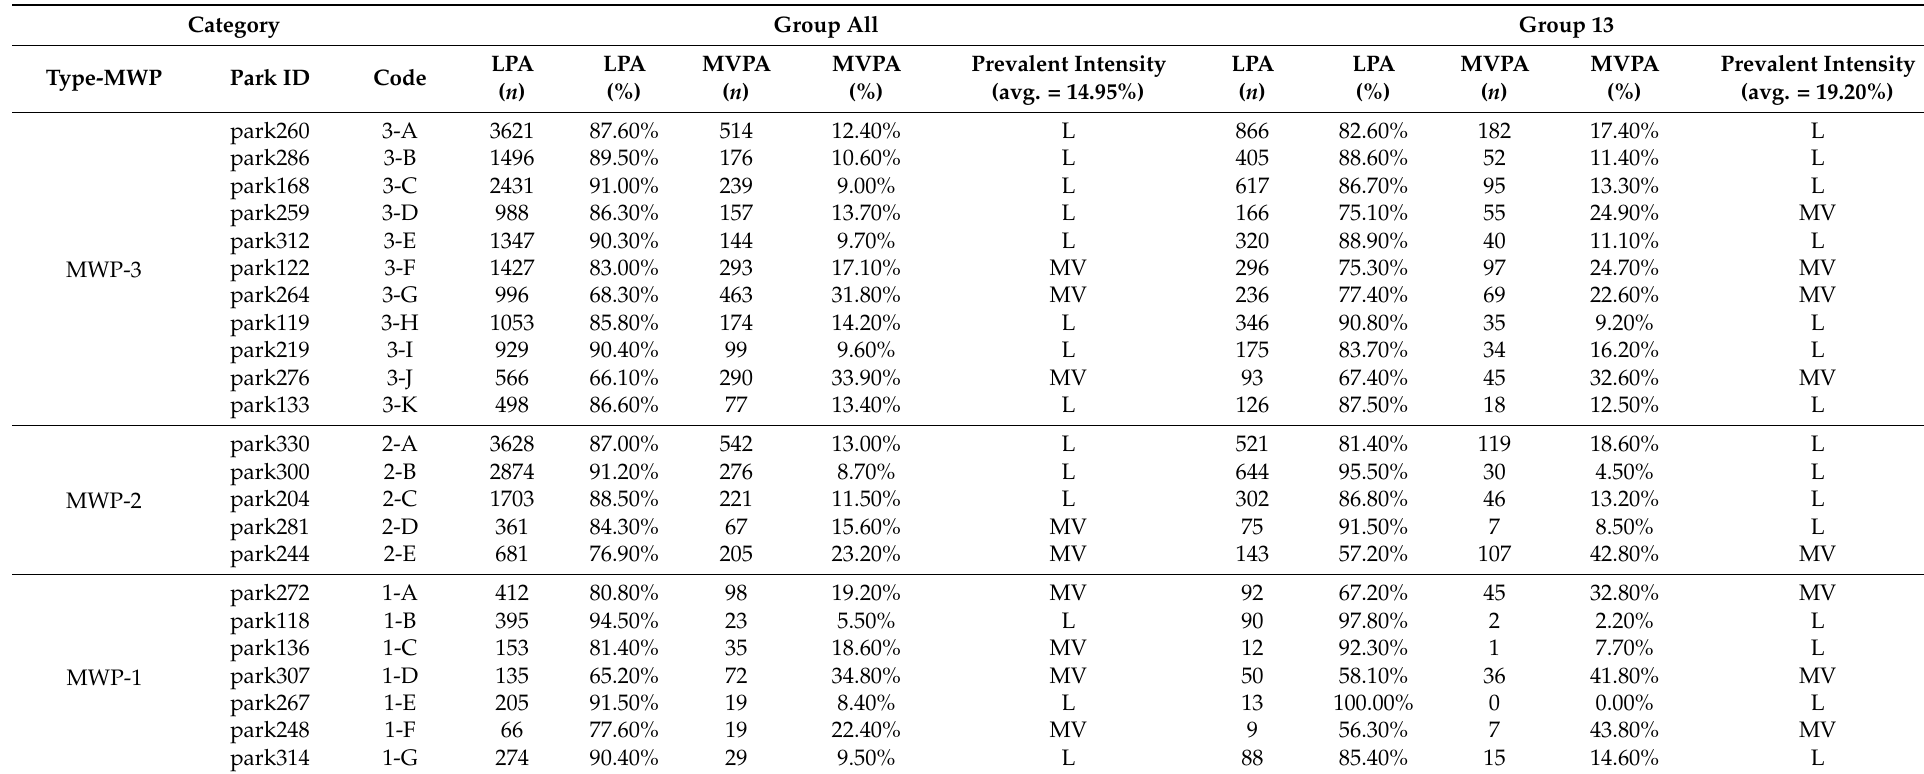
Table 7. Prevalent intensity of parks, finding ‘intensely-walked